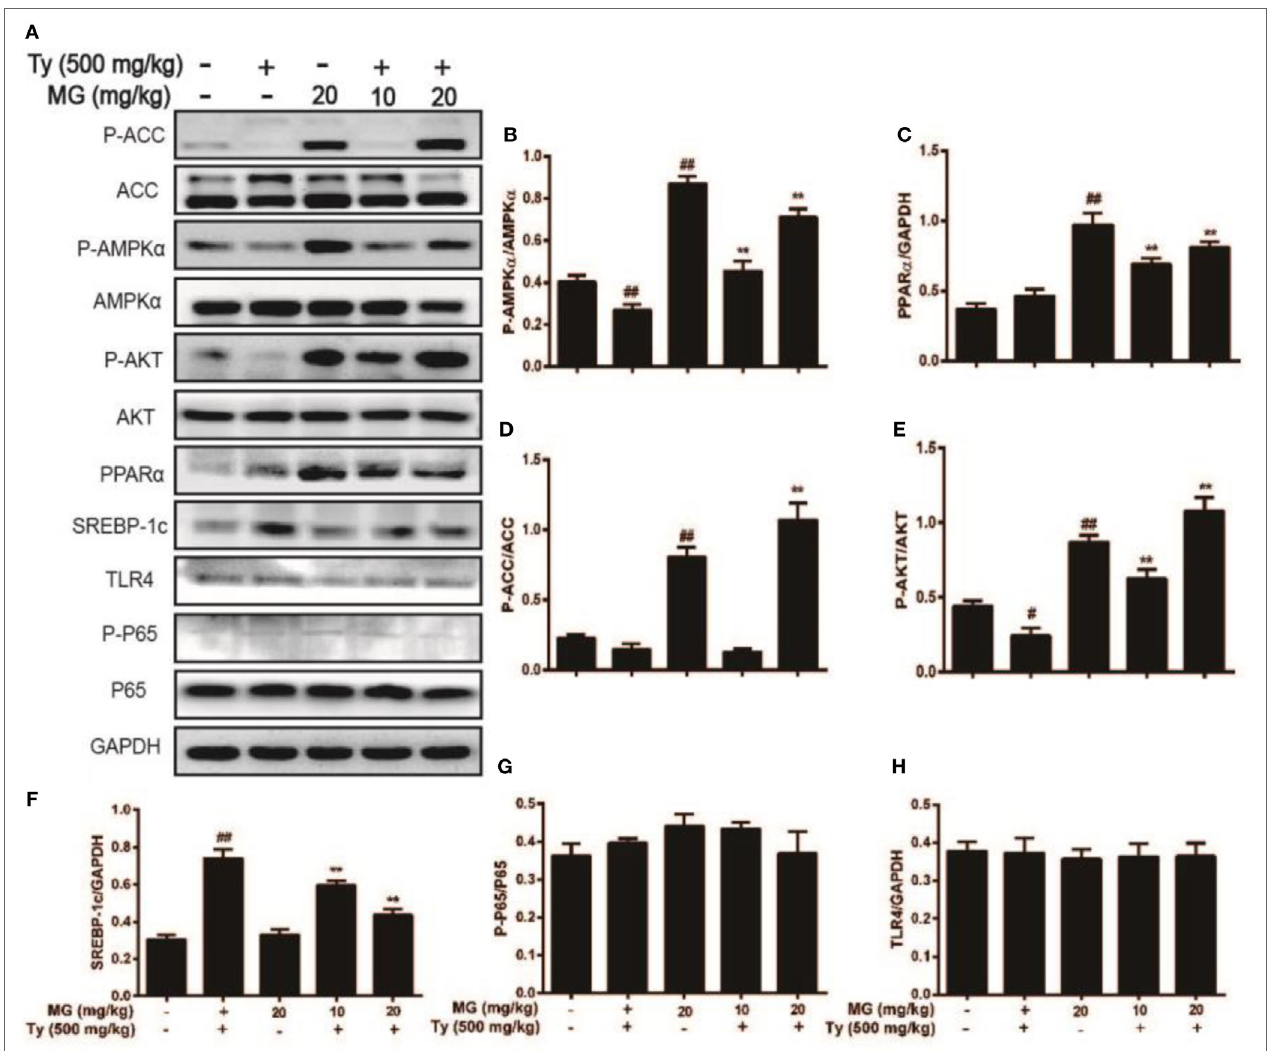
FigUre 9 | Effect of magnolol (MG) treatment on AMPK, peroxisome proliferator-activated receptor α (PPAR α ), AKT, and sterol regulatory element-binding protein 1c (SREBP-1c) in tyloxapol (Ty)-induced hyperlipidemia mice. Mice were administered MG (10 and 20 mg/kg) for 1 h. Afterward, the mice were injected with Ty (500 mg/kg) for 12 h. Liver tissues were gathered and analyzed by western blot. (a) Effects of MG on P-acetyl-CoA carboxylase (ACC), ACC, P-AMPK α , AMPK α , P-AKT, AKT, PPAR α , SREBP-1c, P-P65, P65, and TLR4 were measured by western blot analysis. (B–h) Quantification of relative protein expression was performed by software analysis. All data are expressed as the mean ± SD of three independent experiments. Statistically significant at # p < 0.05 and ## p < 0.01 vs. the control group and ** p < 0.01 vs. the Ty-stimulated group (one-way ANOVA followed by Tukey’s